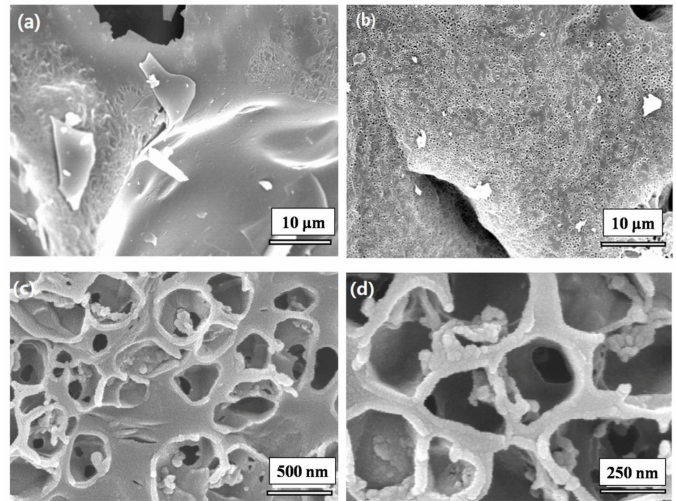
Figure 1. ( a ) The scanning electron microscope (SEM) image of starch-derived carbon; ( b )–( d ) various magnification SEM images of starch-derived carbon foam SCF.